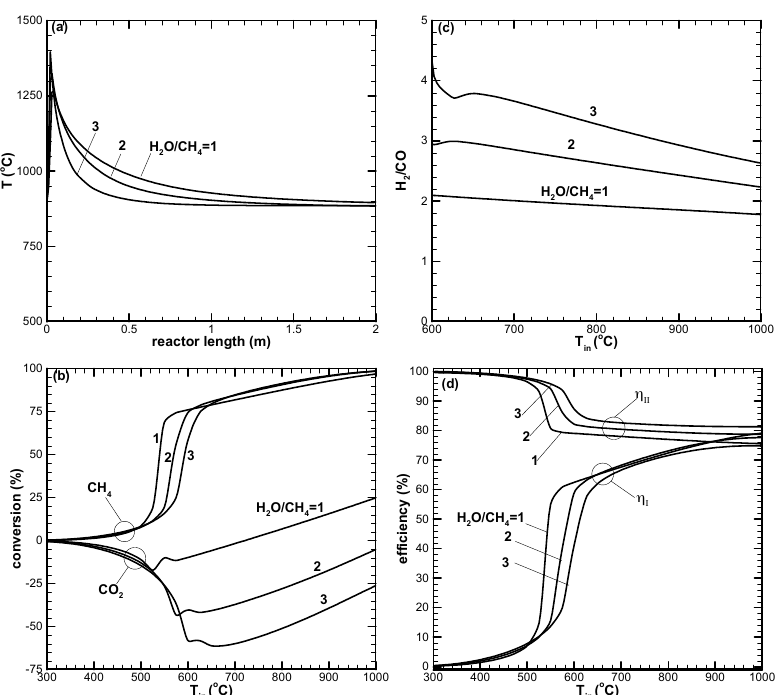
Figure 8. Effect of H 2 O/CH 4 ratios on the TR process. H 2 O/CH 4 is varied from 1 to 3 while the other parameters were kept unchanged, as listed in Table 1. ( a ) Temperature variation along reactor with T in = 900 ◦ C; ( b ) CH 4 and CO 2 conversions; ( c ) H 2 /CO ratio; and ( d ) first- and second-law efficiencies.